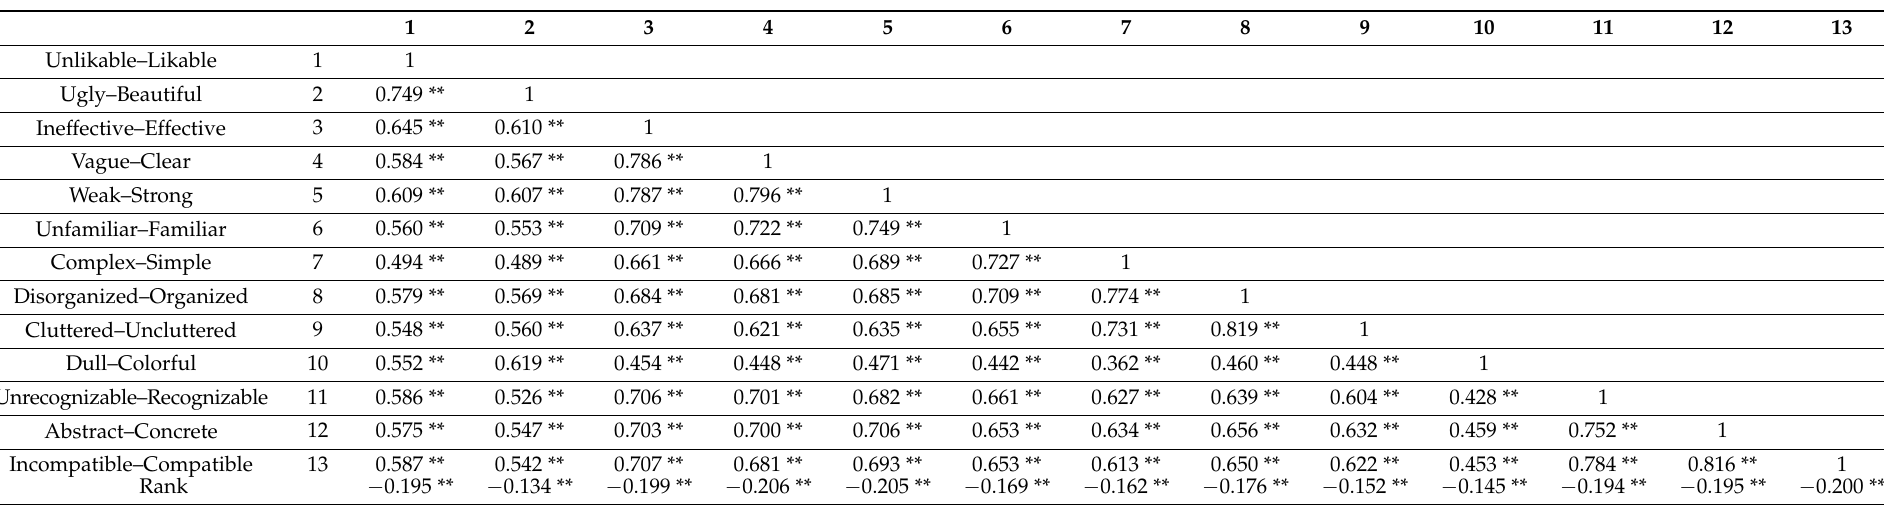
Table 7. Spearman’s rank correlation result between ranking and 13 semantic